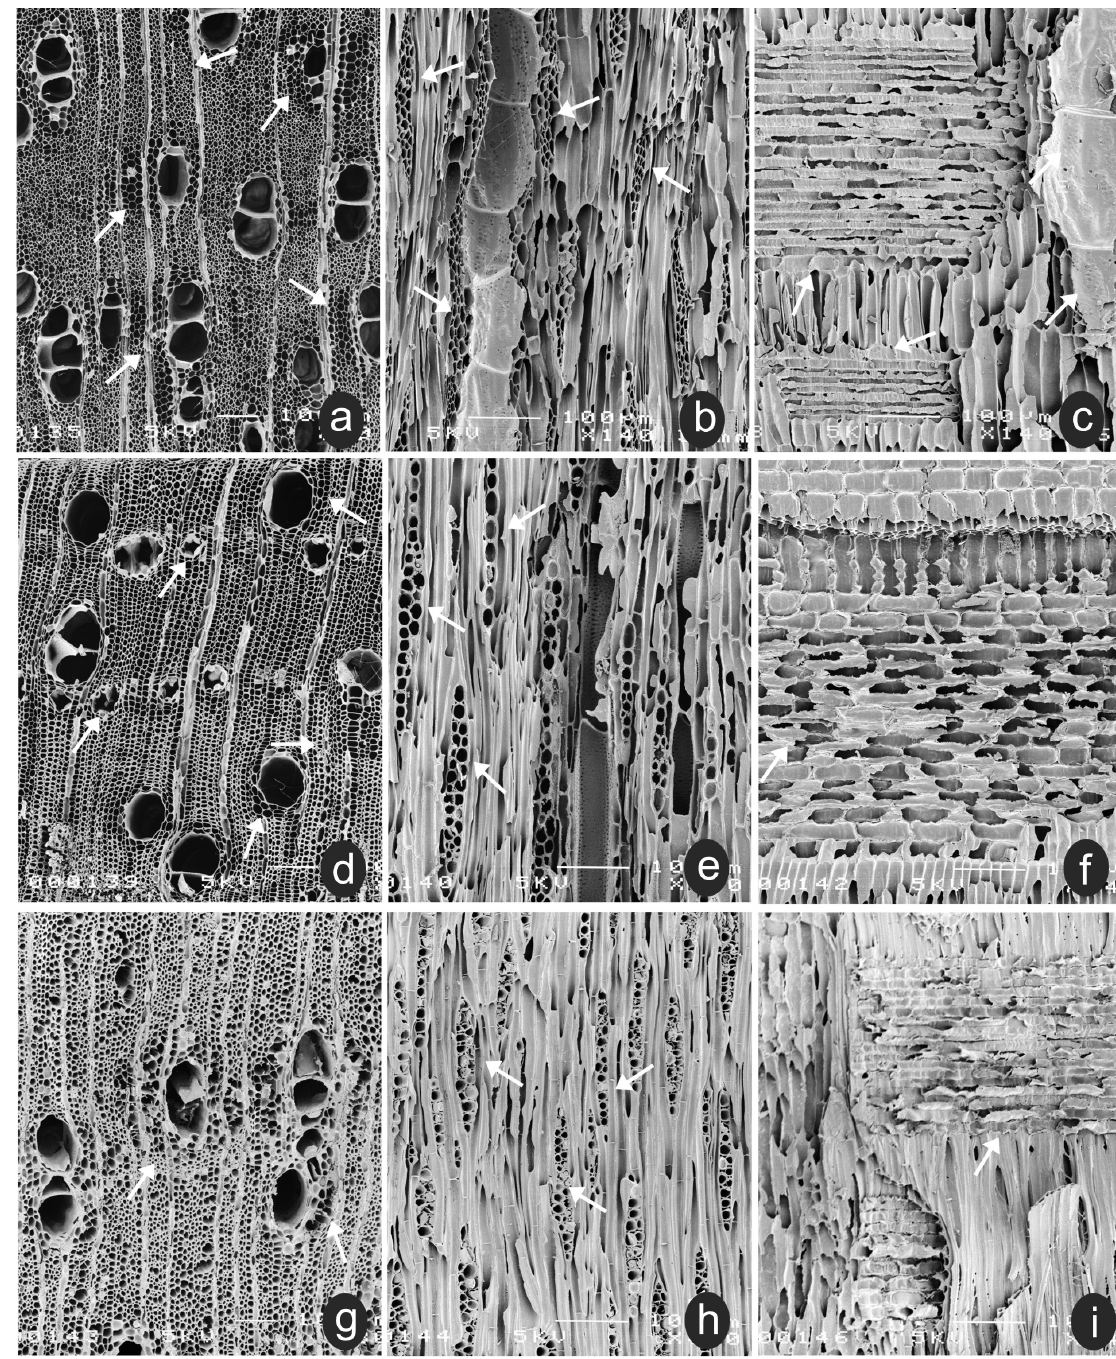
Figure 3. a-b-c. Bauhinia forficata Link. (Fabaceae Caesalpinioideae / BCTw8774) [Arrows: a- axial parenchyma; b- rays; c- row of square marginal cells siding procumbent ray cells; vessel-ray pits larger than intervessel pits (right arrows)]. d-e-f. Copaifera langsdorffii Desf . (Fabaceae Caesalpinoideae / SPSFw139) [Arrows: d- axial canals; axial parenchyma; growth ring (horizontal arrow); e- rays; f- ray cells]. g-h-i Peltophorum dubium (Spreng.) Taub. (Fabaceae Caesalpinioideae / BCTw s/nº) [Arrows: g- axial parenchyma; h- rays; i ray cells]. a-d-g: Transverse section. – b-e-h: Tangential section. – c-f-i Radial section. Bars = 100